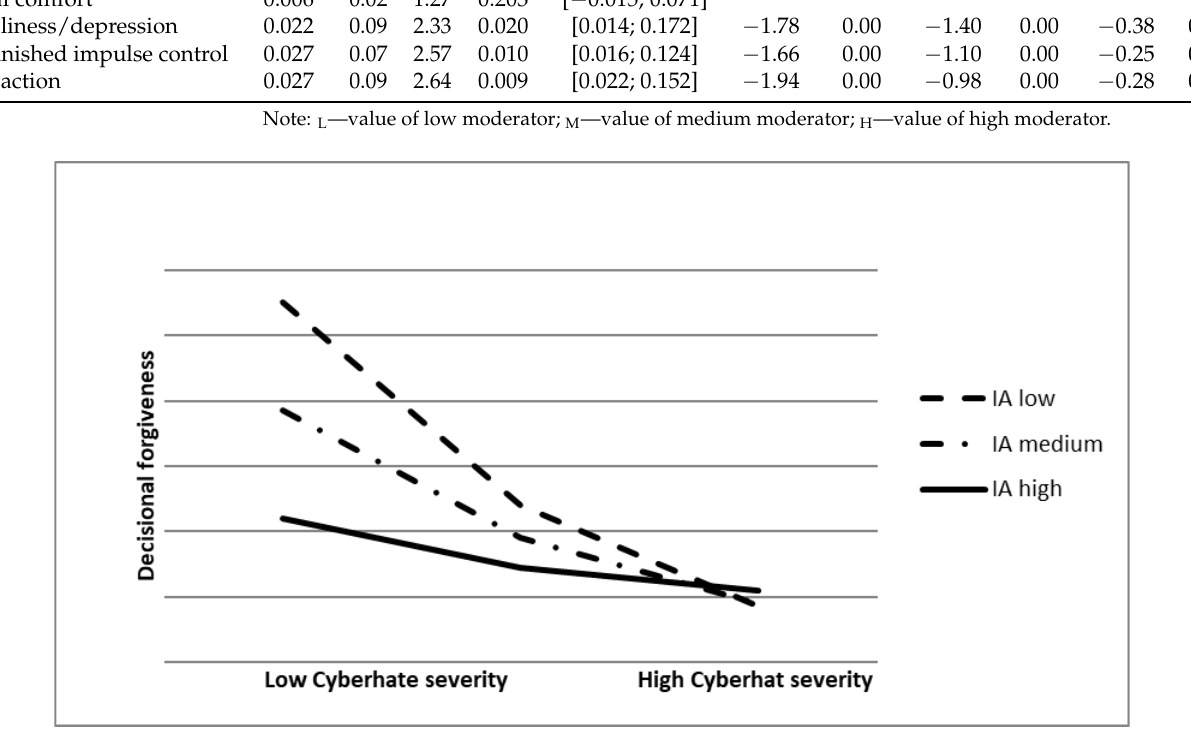
Figure 1. Graphical depiction of moderation results. Note: IA — Internet addiction. Table 2. Results of moderation analysis for the independent variable — cyberhate severity — and de- pendent variable — decisional forgiveness.